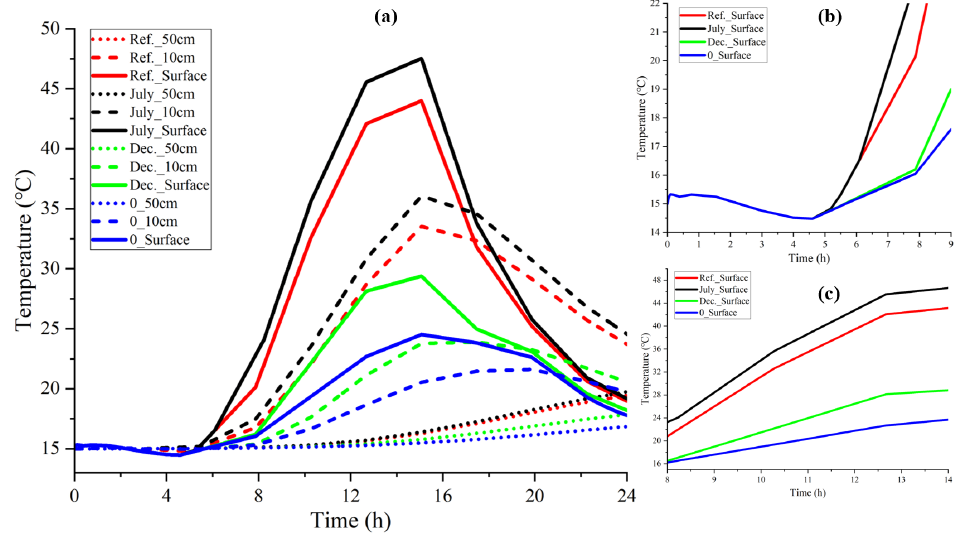
Figure 12. Impact of solar radiation on the temperature distribution (0 W/m 2 set as blank control group) ( a ) Three depths: 0 m, 10 cm, 50 cm; ( b ) Surface Temperature from 0–9 o’clock; ( c ) Surface Temperature from 8–14 o’clock.